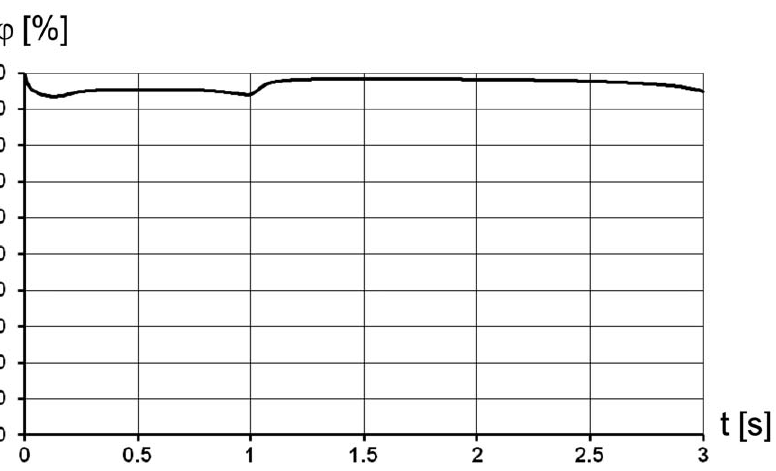
Figure 7. Relative humidity of the air passing through the syrinx in one breathing cycle. 1 s corresponds to end-inspiration.